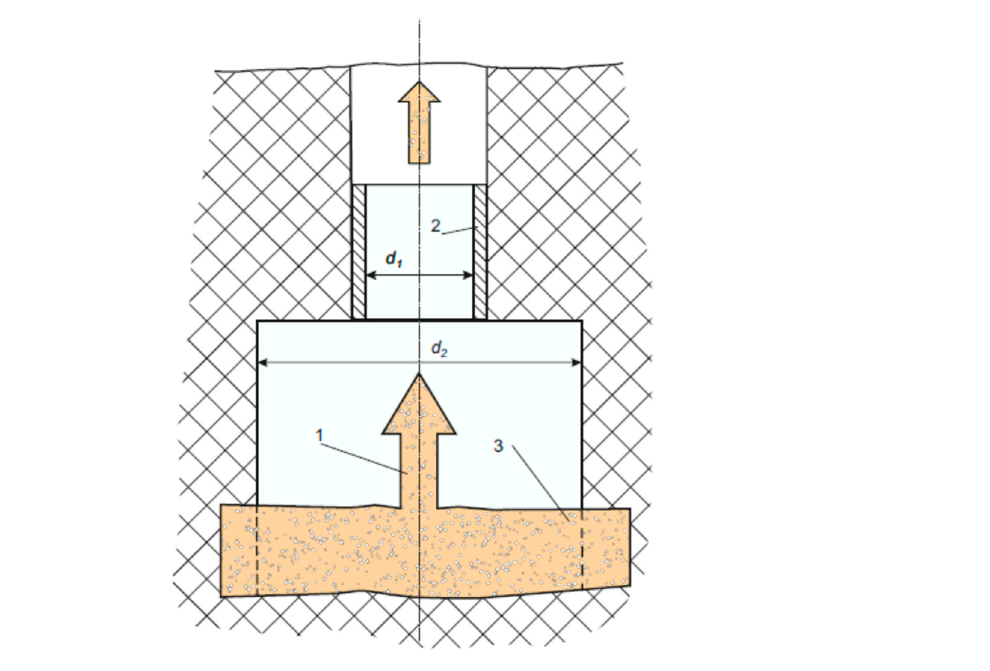
Figure 4. Schematic of hydrodynamic tract: 1—oil flow, 2—acoustic emitter, 3—oil-saturated reservoir.